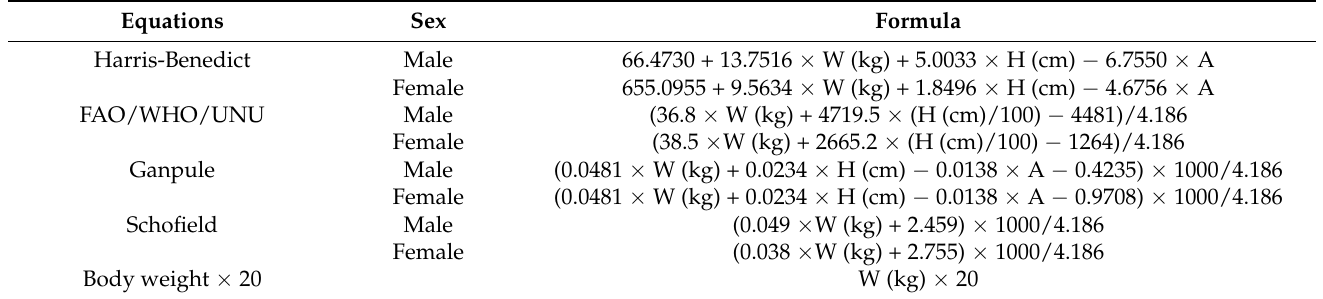
Table 1. Characteristics of equations for the prediction of resting energy expenditure (REE).